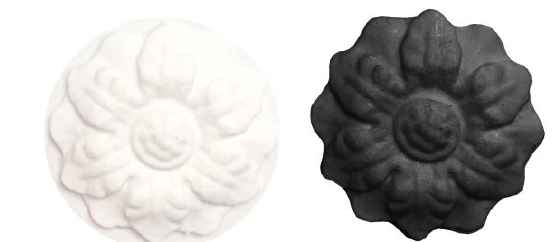
Figure 19. Printed object obtained with the described settings, white version for the test and black for the door